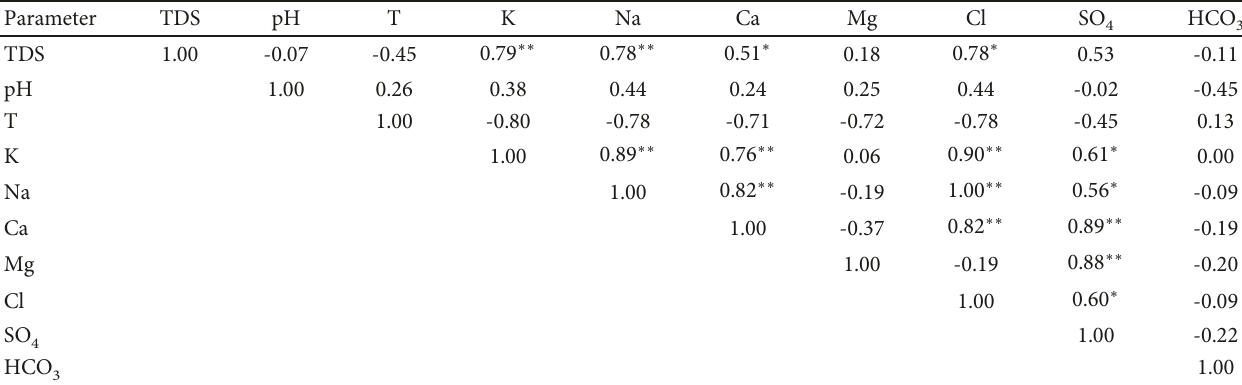
Table 4: Correlation matrix of physical and chemical parameters of the saline and salty springs (well) in northeastern Sichuan Basin. Parameter